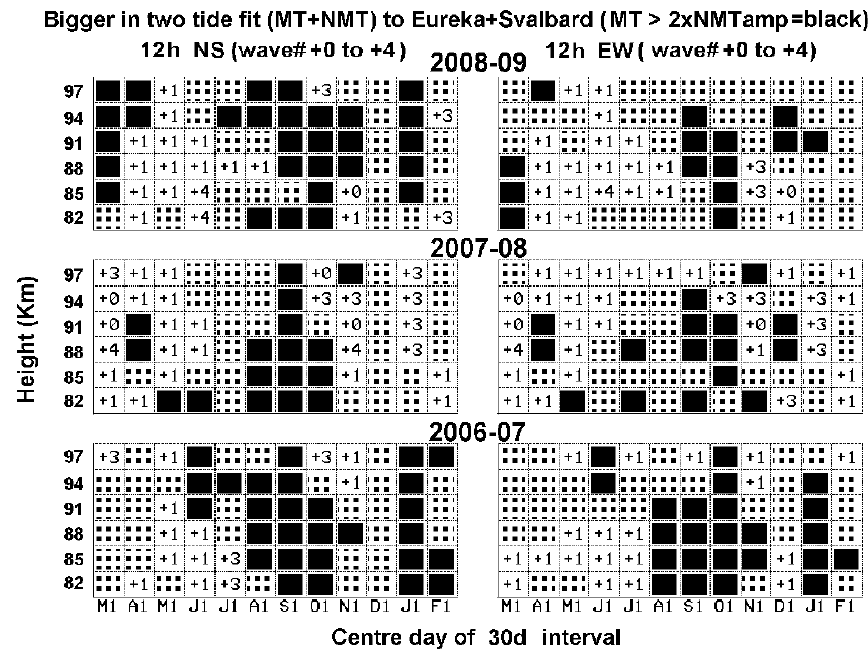
Fig. 7. Two-tide fits, using the wave number of the Semi-Diurnal MT ( s = 2) plus one of a range of NMT, were used to find the relative sizes: a black square is chosen if MT is greater than twice any NMT value; a grey square is chosen when one or more NMT values are smaller then MT, but greater than 0.5 of MT; the wave-number “ s ” is chosen that has the largest NMT [relative to the corresponding MT amplitude] of all of the fits. Wave-numbers ( s = 0 to + 4) are appropriate to non-linear interaction with the SPW S = 1 or 2.